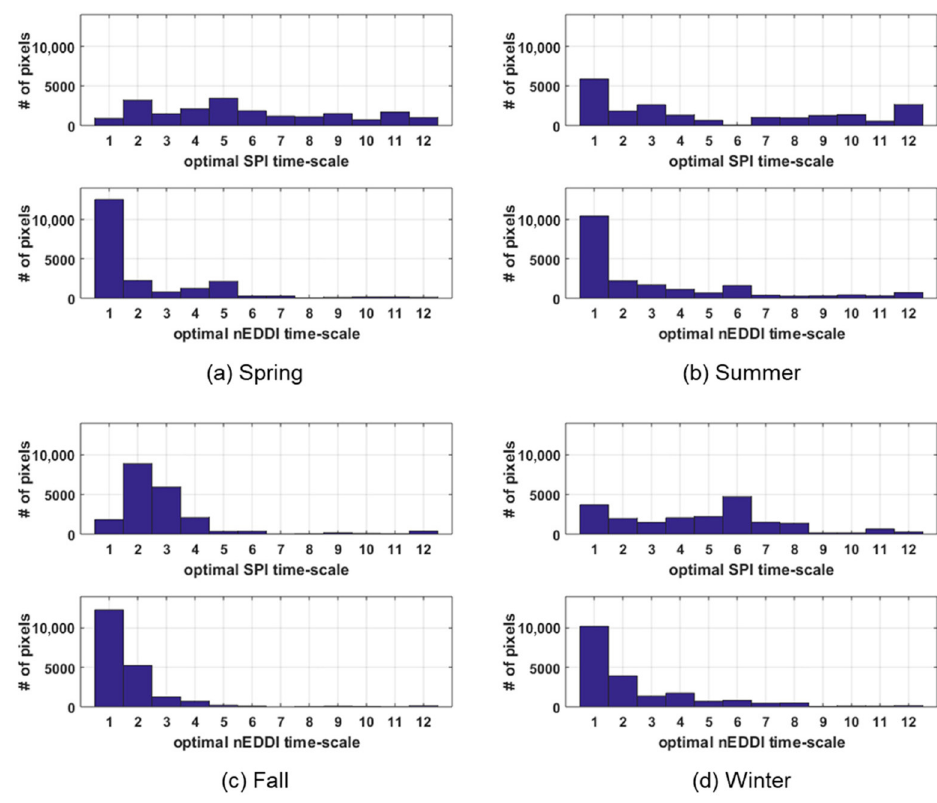
Figure 7. The optimal time scale for SPI and nEDDI